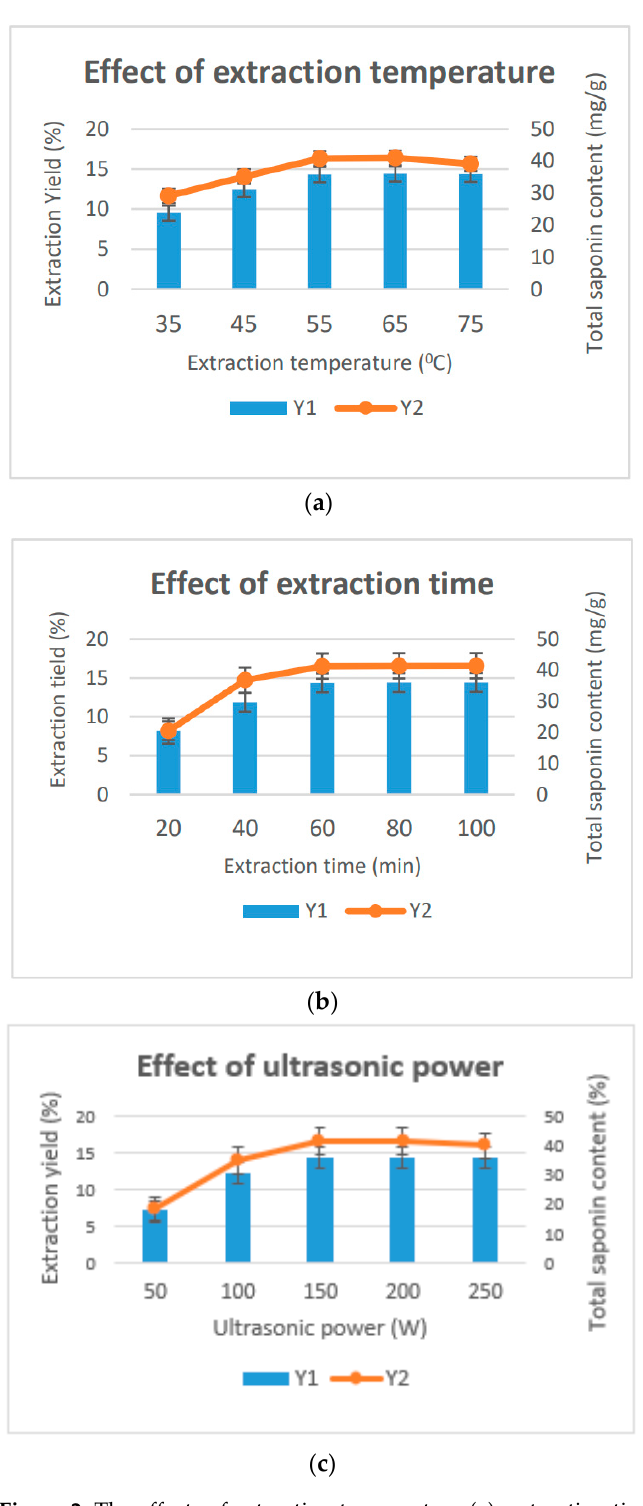
Figure 2. The effects of extraction temperature ( a ), extraction time ( b ), and ultrasonic power ( c ) on extraction yield and TSC content from the root of P. fruticosa (L.) Harms.